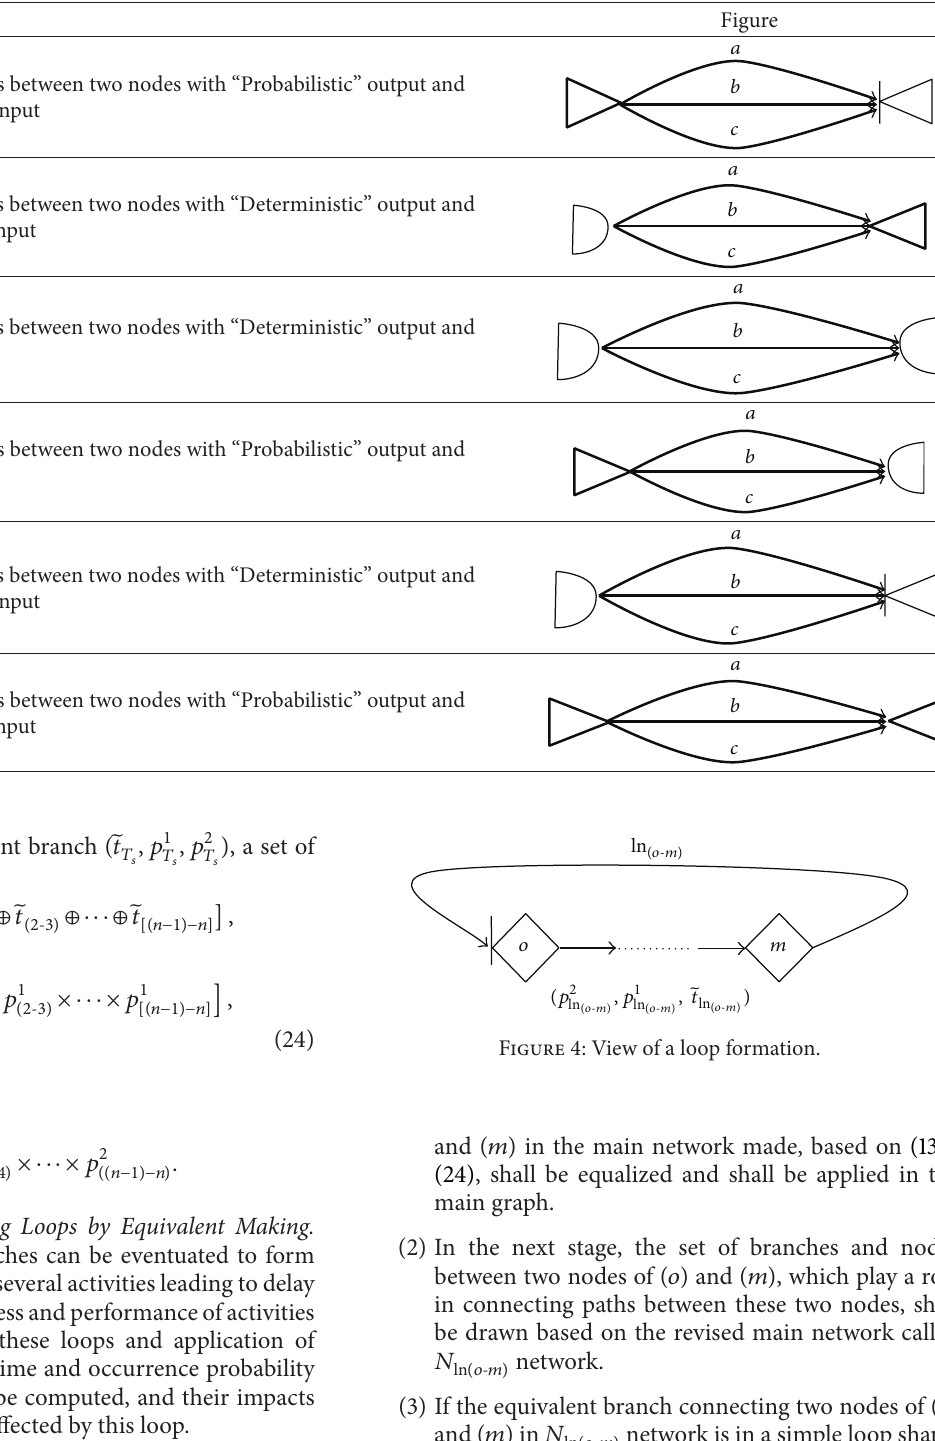
Table 3: Six states of parallel branches between two different nodes.